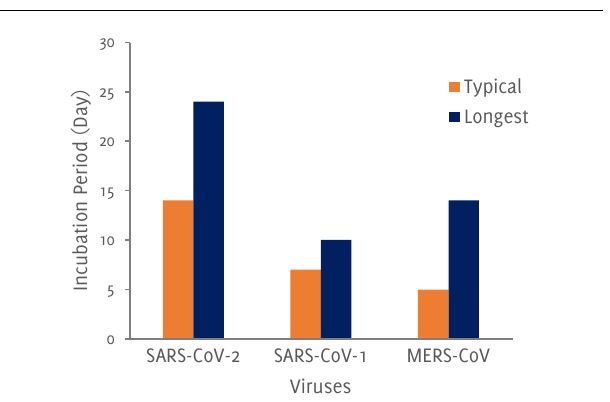
Figure 3. Incubation periods of the